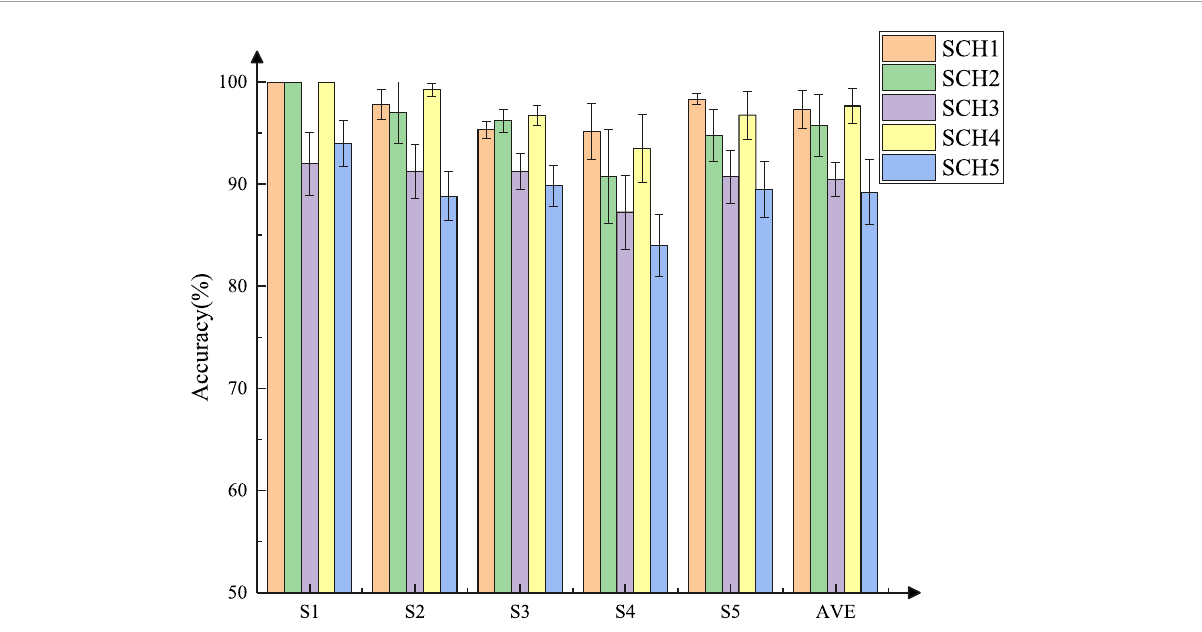
FIGURE6 The accuracy of each subject under five classification schemes when the number of channels was